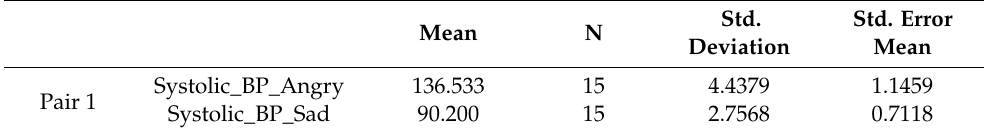
Table 11. Paired samples statistics for systolic BP (angry to sad state).